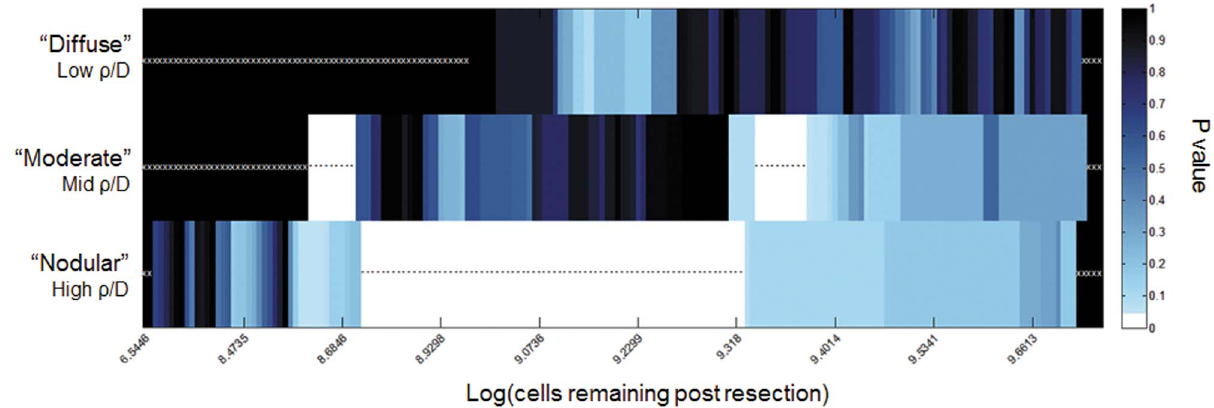
Figure 6. Results of iterative Kaplan-Meier Analysis in each invasiveness cohort. Number of cells remaining was calculated for each patient, based on their r /D and measured residual enhancing disease. Each possible threshold was iterated through to separate the patients into large and small residual tumor cell population cohorts. White boxes correspond to thresholds separating patients into groups with significantly different (p , 0.05) survival. White stars indicate tests with no p-value, as the threshold did not separate the patients in the given invasiveness cohort into two groups. Black asterisks indicate tests with p , 0.05. Black bins with white x’s indicate no the threshold did not separate the patients in the given invasiveness cohort into two groups. For example, for the diffuse case (Figure 3, top row), the black bins with white x’s represent the fact that even GTR was unable to achieve a remaining cell burden less than the cutoff (up to approximately 10 9 ). Further, amongst the most diffuse gliomas, no threshold for a residual cells following resection was found to be significant of outcome represented visually as the lack of a white bar in the top row. Although less dramatic, the moderate cohort was unable to equate a GTR with , 10 8.5 cells remaining represented by the black bars with white x’s to the left on middle row of Figure 3. While resection of tumors in the nodular cohort were able to attain residual disease burdens at all levels down to , 10 7 cells.